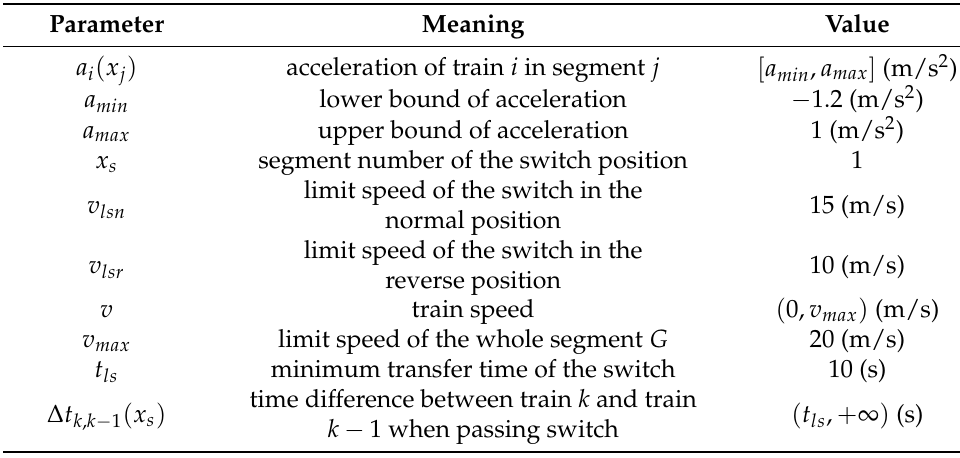
Table 1. List of parameters in